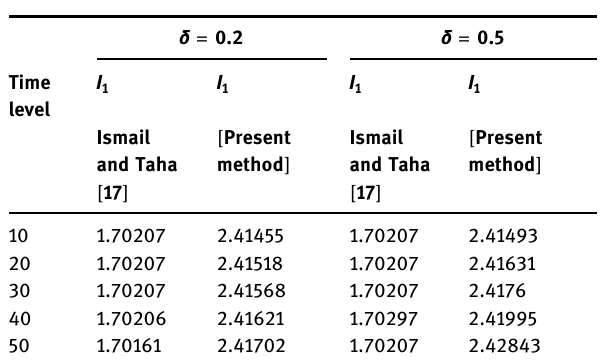
Table 6: Comparison of conserved quantity for parameters = N 201 , = t Δ 0.01